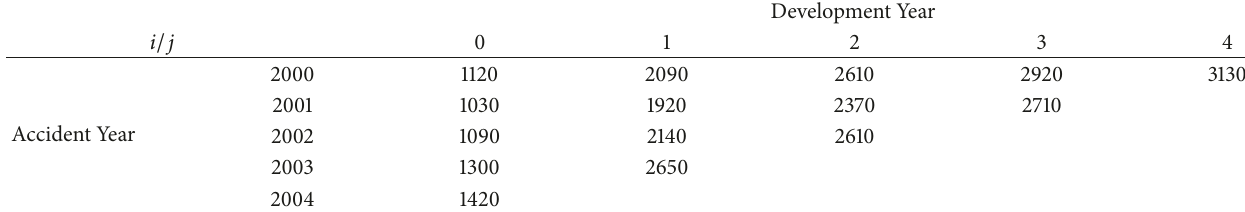
Table 2: Numerical example from